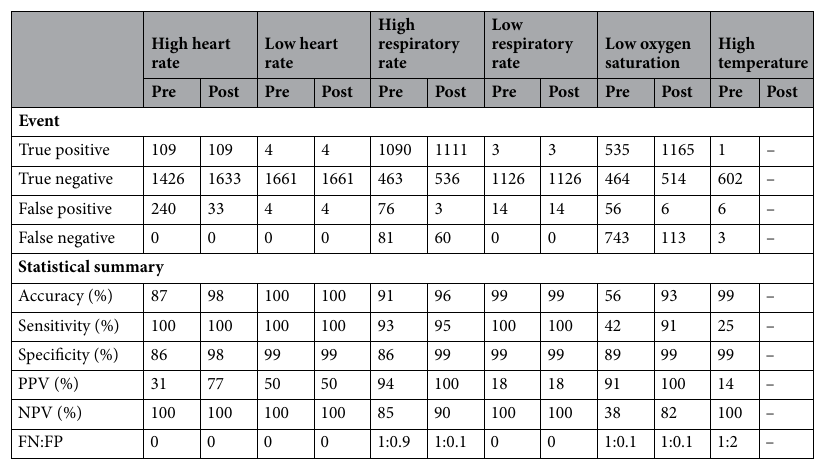
Table 3. Clinical event detection. Pre-adjudication (Pre); post-adjudication (Post); positive predictive value (PPV); negative predictive value (NPV); false negative event to false positive event ratio (FN:FP). Accuracy = (True positive + True negative)/(True positive + True negative + False negative + False positive); Sensitivity = True positive/(True positive + False negative); Specificity = True negative/(True negative + False positive); PPV = True positive/(True positive + False positive); NPV = True negative/(True negative + False